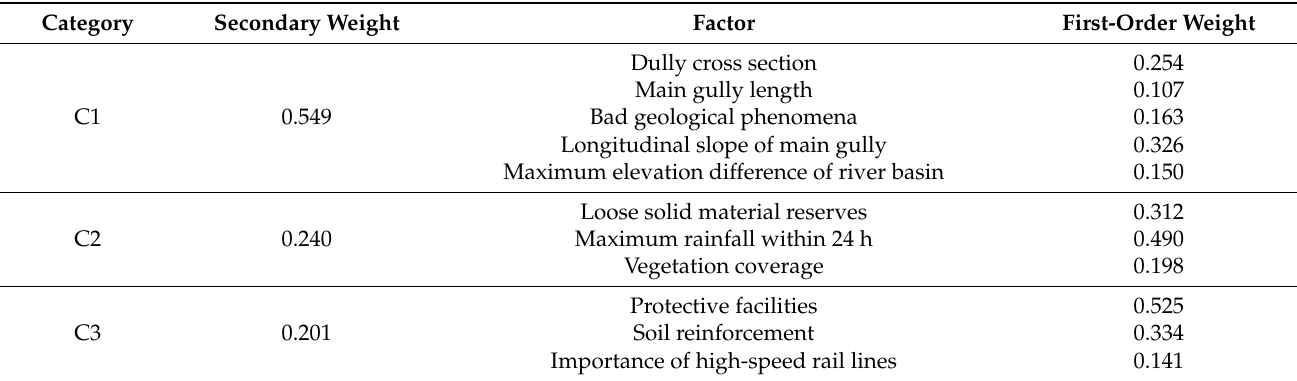
Table 3. Evaluation factor weight